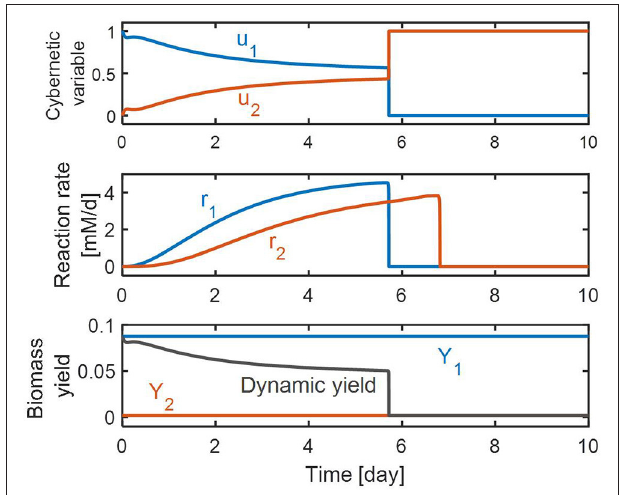
FIGURE 4 | Model predictions of the dynamic changes in cybernetic variables (top) , reaction rates (middle) , and biomass yield (bottom) . In the bottom panel, Y 1 and Y 2 denote the stoichiometric biomass yields associated with NO − 3 and NO − 2 reductions,